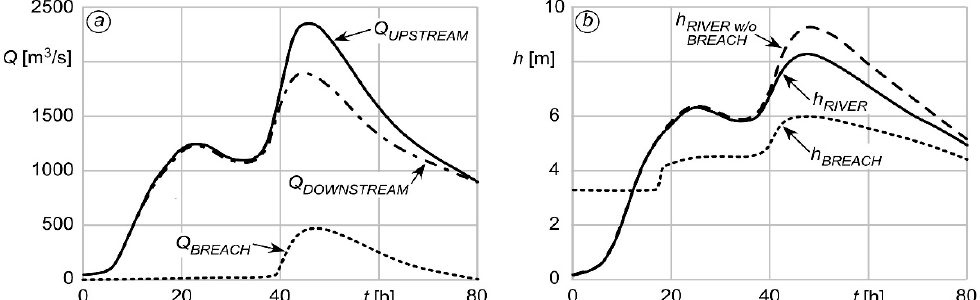
Figure 5. Hazard scenario. ( a ) Discharge hydrographs within the Piave River upstream (solid line) and downstream (dash-dotted line) of the levee breach location and through the breach (dotted line); ( b ) water levels within the Piave River with (solid line) and without (dashed line) the breach formation, and just outside of the levee breach location (dotted line).